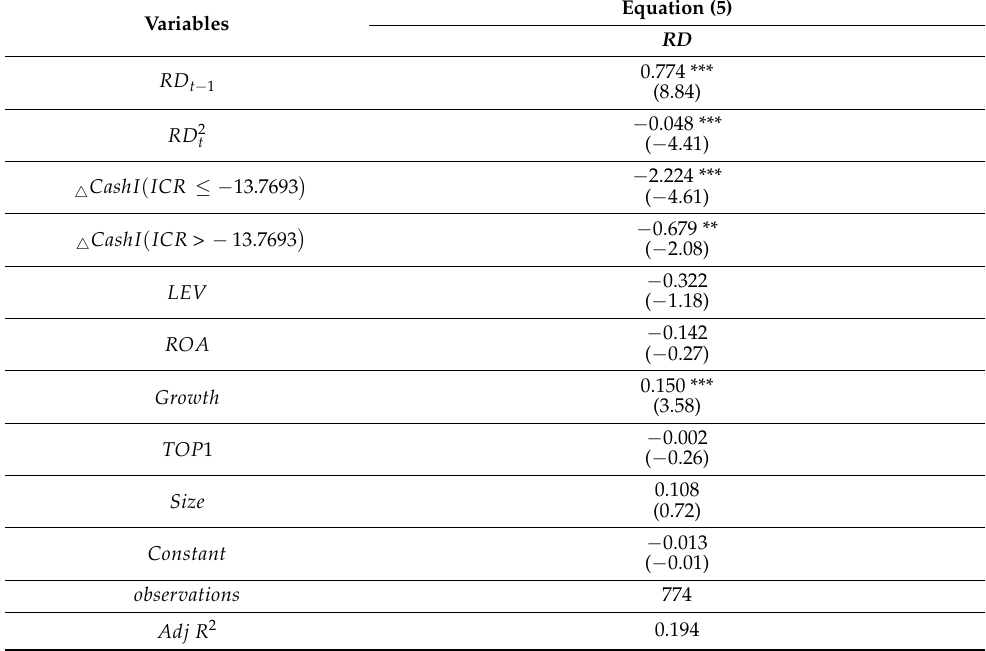
Table 7. Financing constraints threshold model